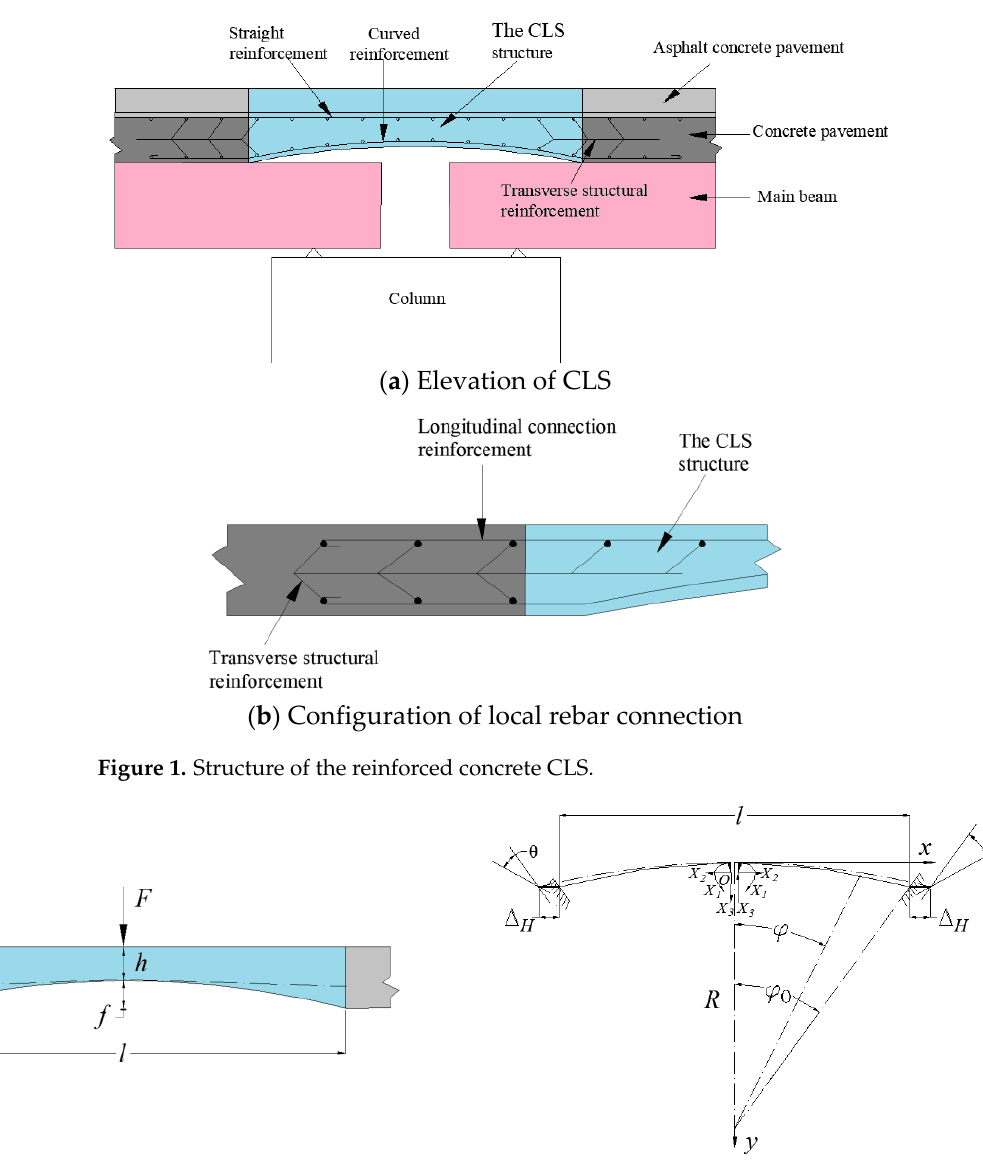
Figure 2. Simplified CLS